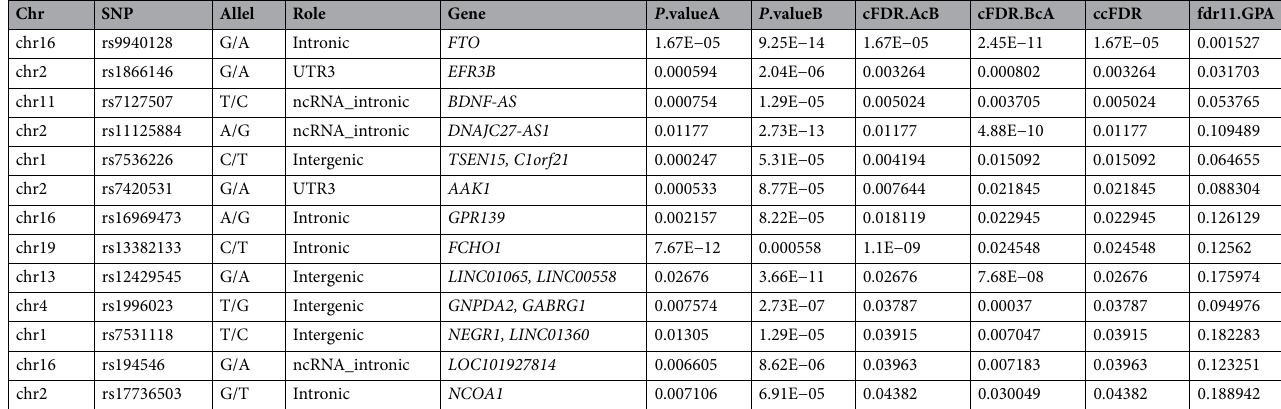
Table 2. The pleiotropic loci identified by cFDR and GPA method ( ccFDR < 0.05 and fdr11.GPA < 0.2). The SNPs are listed with their chromosomal, allele, role, annotated genes, original p -value for each phenotype, cFDR value for each phenotype, ccFDR and fdr.11.GPA values. A means CAD and B means CBMI. Chr: chromosom, ccFDR: conjunctional conditional false discovery rate, fdr.11GPA: false discovery rate of GPA when the SNP was associated with both phenotypes, GPA: genetic analysis incorporating pleiotropy and